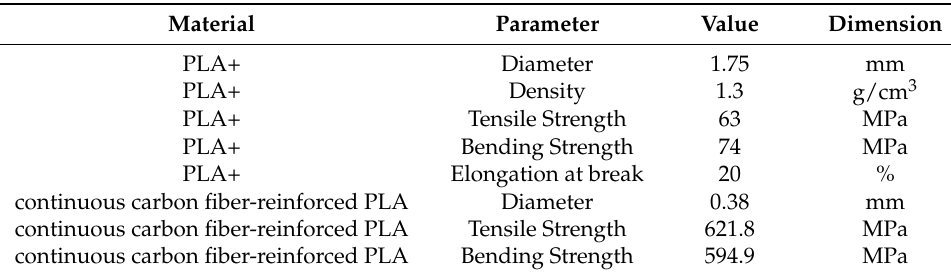
Table 3. Print material